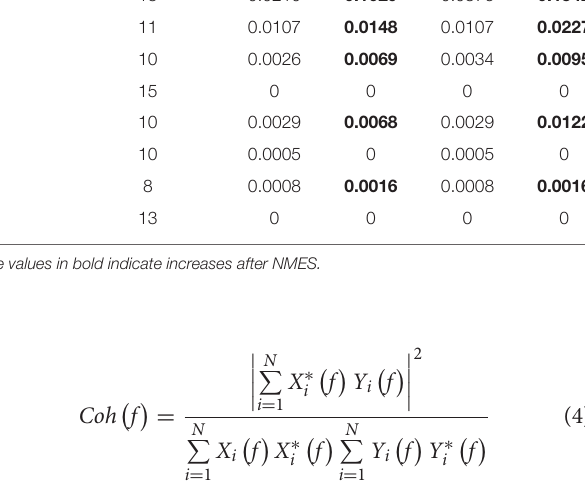
TABLE 1 | The peak current and C3 EEG-EMG coherence for individuals. No. of Peak current Max of Coh s Area of Coh s participant (mA)